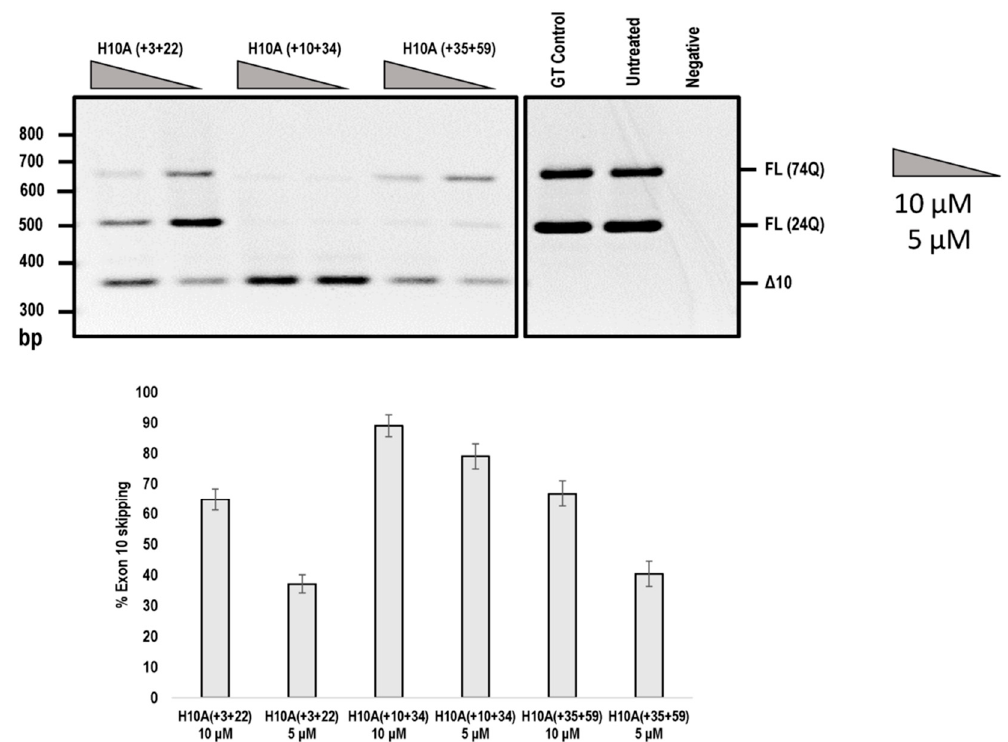
Figure 5. Agarose gel fractionation of ATXN3 transcript products from SCA3 patient derived fibroblasts, following PMO transfection at concentrations of 10 and 5 µ M. Fractionation shows full-length products (FL 74Q; FL 24Q) and removal of exon 10 ( ∆ 10) (product size of 362 bp). Densitometric analysis of the gel image is shown below the gel (means plus error bars. Error bars = standard deviation, n = 3). (FL = full-length, ∆ 10 = exon skipped product, GT = Gene Tools control PMO, Q = glutamine).